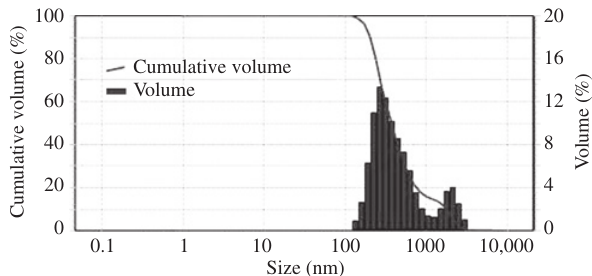
Figure 2: Particle size distribution curve of iron nanoparticles (INPs) complexes which were obtained by particle size